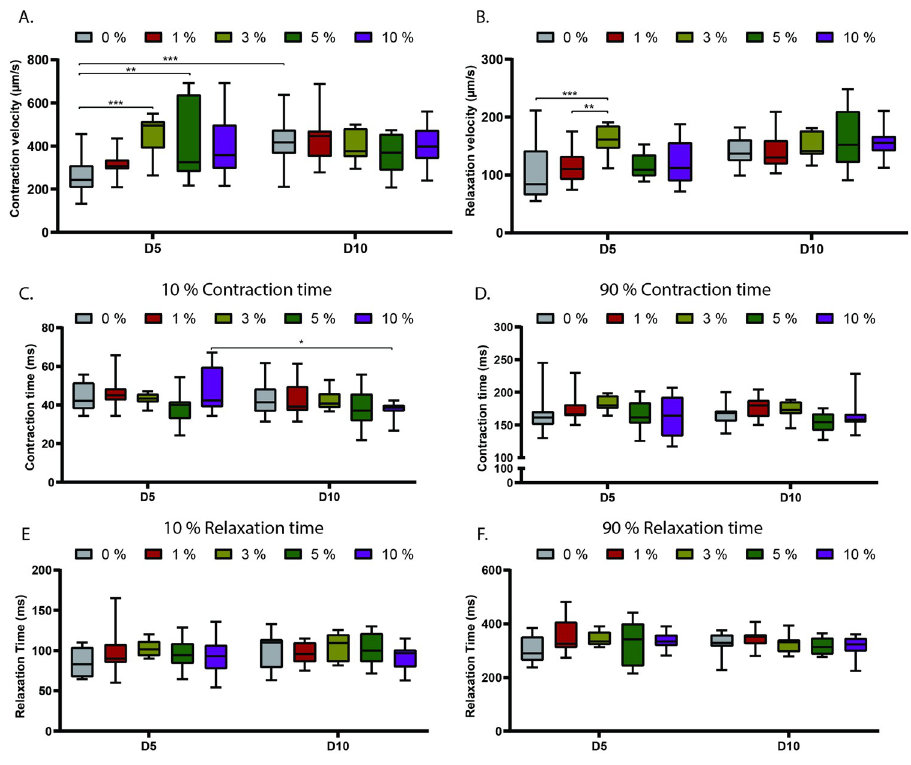
Fig 7. Contraction kinetics of EHTs with different ratio of human adult cardiac fibroblast (HCF). (A-B) Contraction (A) and relaxation (B) velocity of EHTs using different ratio of HCF at day 5 and 10. (C-D) Time to reach 10% (C) and 90% (D) of contraction using different ratio of HCF at day 5 (D5) and day 10 (D10). (E-F) Time to reach 10% (C) and 90% (D) of relaxation using different ratio of HCF at day 5 (D5) and day 10 (D10). Data shown as means, maxima and minima; Two-way ANOVA plus Tukey’s test for comparisons among ratios of HCF; � = p < 0.05; �� = p < 0.01; ��� = p < 0.001; ���� = p < 0.0001, (N = 3).